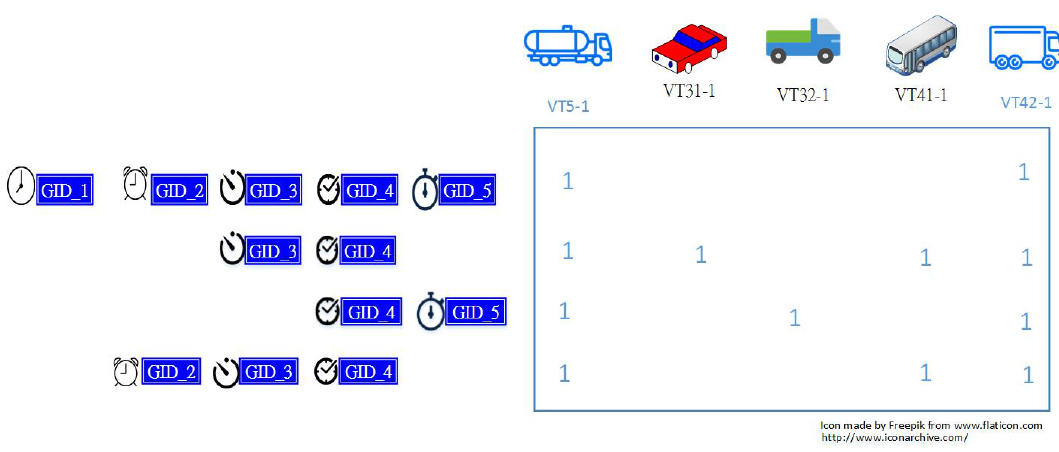
Figure 3. Example: the significant travel time patterns extracted from the gentry timestamp sequences in Figure 2; “Reproduced with permission from 2017 International Conference on Applied System Innovation (ICASI); published by IEEE,